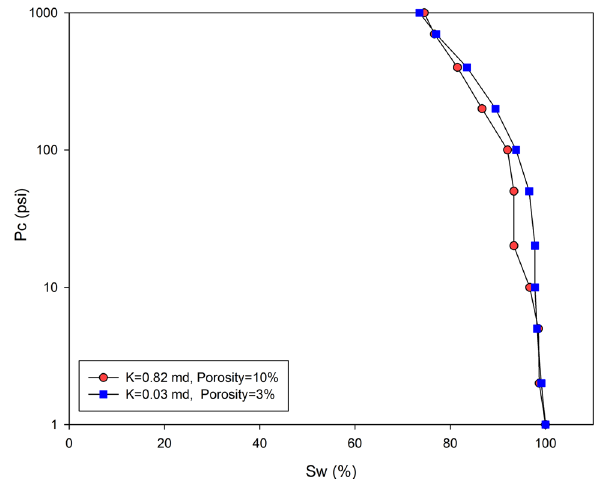
Fig. 6 Capillary pressure plots of the samples taken from top seal in Well B-2. Two samples show a high displacement pressure to be effi- cient as a seal for Main Ilam formation